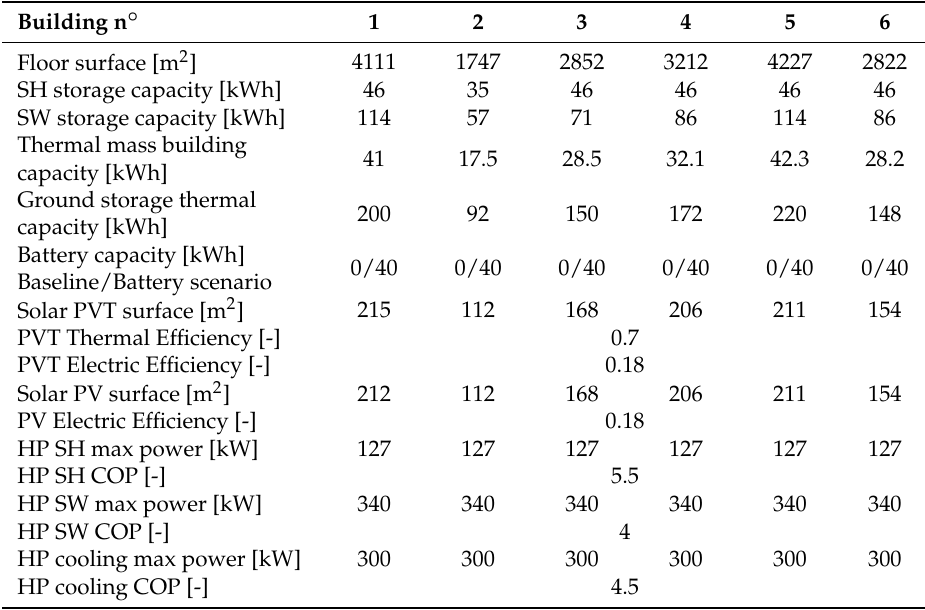
Table 1. Energy infrastructure